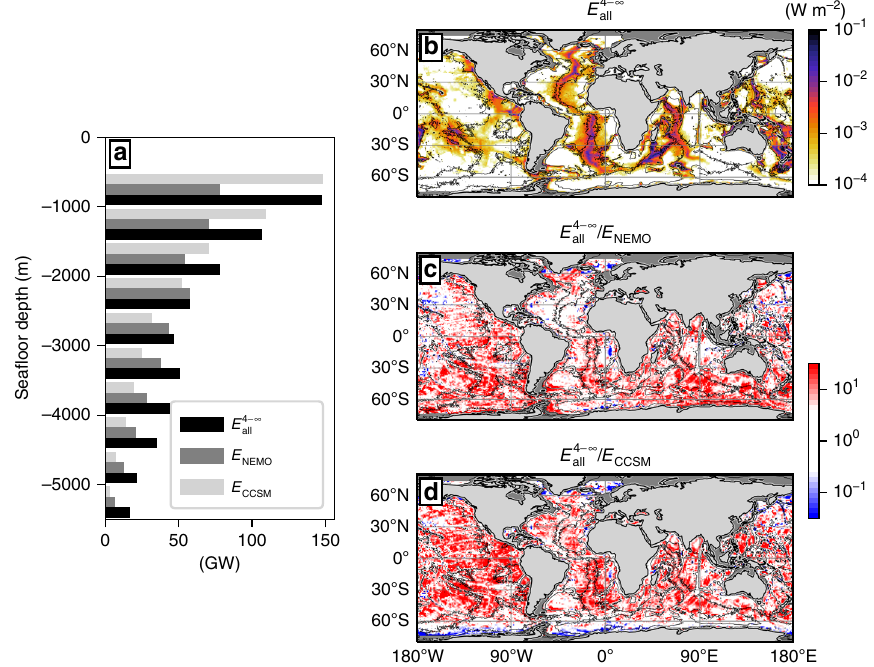
Fig. 7 Comparison of proposed and currently used estimates of near- fi eld tidal mixing. a Distribution of energy dissipation as a function of sea fl oor depth for the three estimates: (black) our proposed estimate, E 4 (cid:1)1 ; (dark grey) E NEMO , based on Nycander ’ s estimate of energy conversion and used in the all NEMO model; and (light grey) E CCSM , based on Jayne and St Laurent ’ s estimate and used in the CCSM4 model. Maps of b E 4 (cid:1)1 = E = E to the currently used ones, c E 4 (cid:1)1 and d E 4 (cid:1)1 NEMO all all